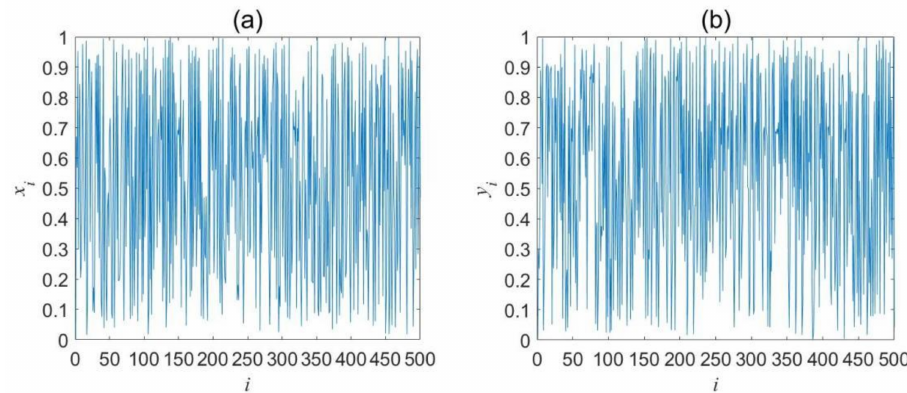
Figure 2. The trajectories of improved sequences: ( a ) x -dimensional variable ( b ) y -dimensional variable.